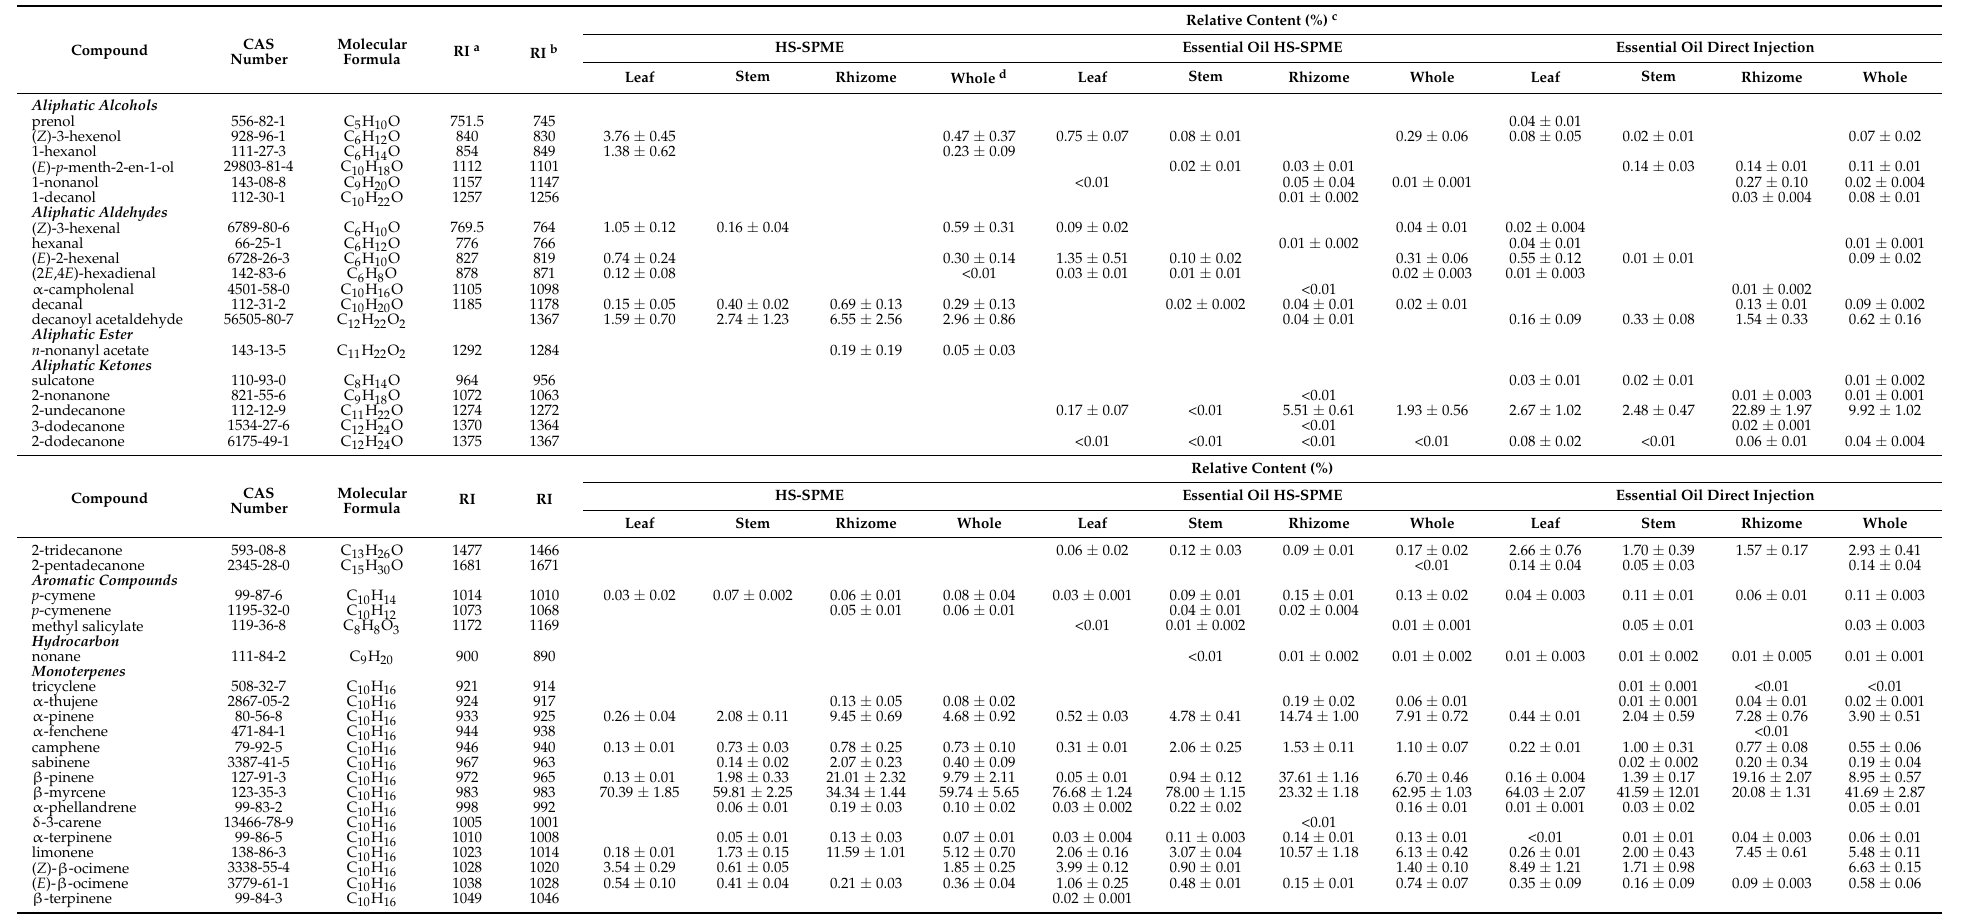
Table 1. Comparison of the content of volatile compounds from different parts of H. cordata and their essential oils, analyzed by HS-SPME and direct injection.